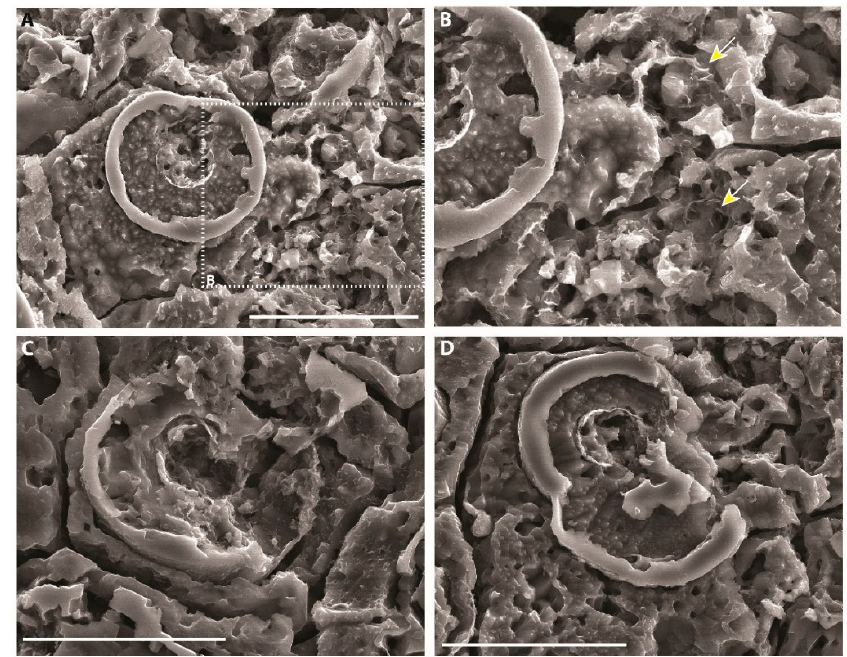
Figure 17. Cont Figure 17. Cont. Figure 17. Cont.